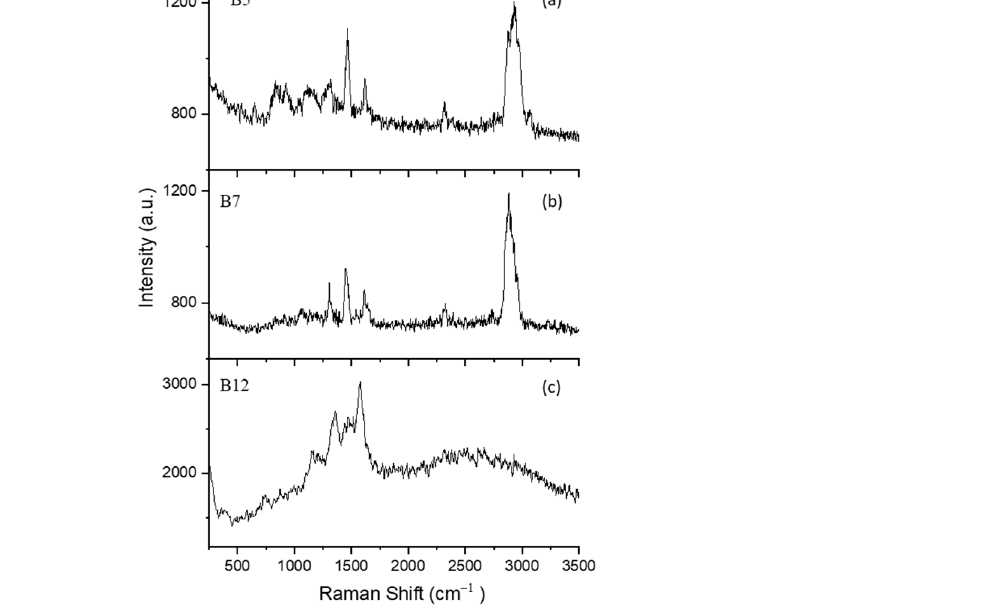
Figure 4. Raman spectra of three types of single, trapped B-vitamins ( a ) B5, ( b ) B7, and ( c ) B12.